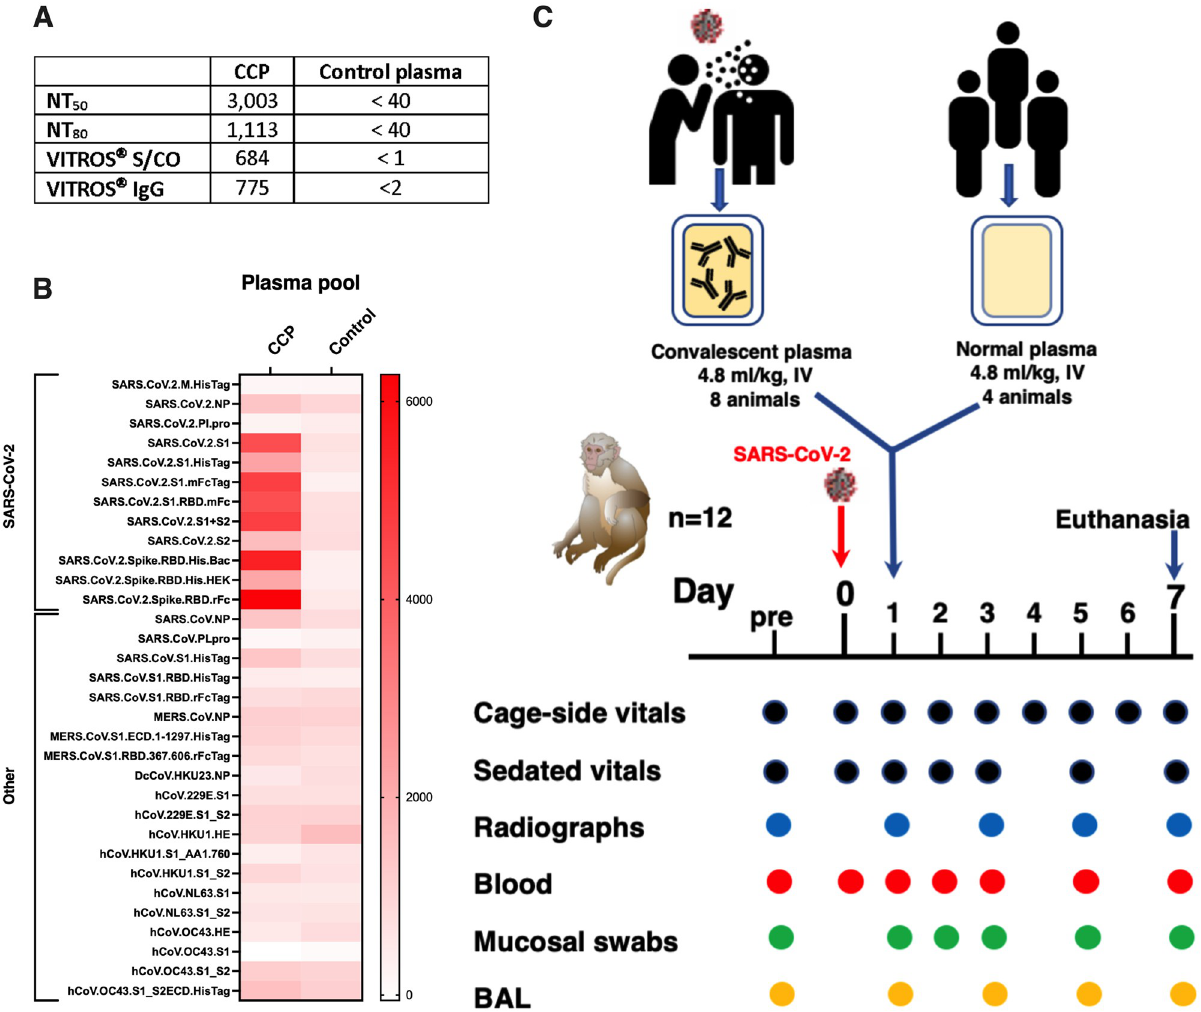
Fig 1. Experimental design & characterization of plasma pools. Two pools of human plasma, COVID convalescent plasma (CCP) and normal plasma, were prepared by mixing plasma of convalescent patients or pre-pandemic uninfected donors, respectively. (A) The 2 plasma pools were characterized for neutralizing antibody titers (NT50 and N80 values), for total spike Ig (by VITROS assay) and IgG (by VITROS Anti-SARS-CoV-2 IgG Quantitative Test; units are BAU/ml). (B) The two plasma pools were also tested by coronavirus microarray assay (COVAM), and signal values are graphed as a heatmap. While the CCP had high reactivity to most SARS-CoV-2 antigens, cross-reactivity of the normal plasma pool to SARS-CoV-2 antigens was very low. Both plasma pools had similar reactivity to non-SARS-CoV-2 antigens. (C) Twelve adult rhesus macaques were inoculated on day 0 with SARS-CoV-2 by both intratracheal and intranasal routes. On day 1, eight animals received a single intravenous infusion with pooled CCP, while the other 4 animals received pooled normal control plasma. Animals were monitored closely for clinical signs (both cage-side and sedated observations) with regular collection of radiographs and samples to monitor infection and disease. On day 7, animals were euthanized for detailed tissue collection and analysis. period (S2 Table and Fig 2B and S1 Fig). Overall, the magnitude of the signals was as expected, based on the CCP being diluted ~1:60-fold upon transfusion in the animals. Mild clinical disease irrespective of treatment Animals were scored daily for several clinical parameters by cage-side observations. Overall, clinical signs were absent or mild-to-moderate (daily scores � 4 out of a maximum of 22) and consisted mostly of nasal discharge. The highest daily score of 4 was recorded for CCP-treated